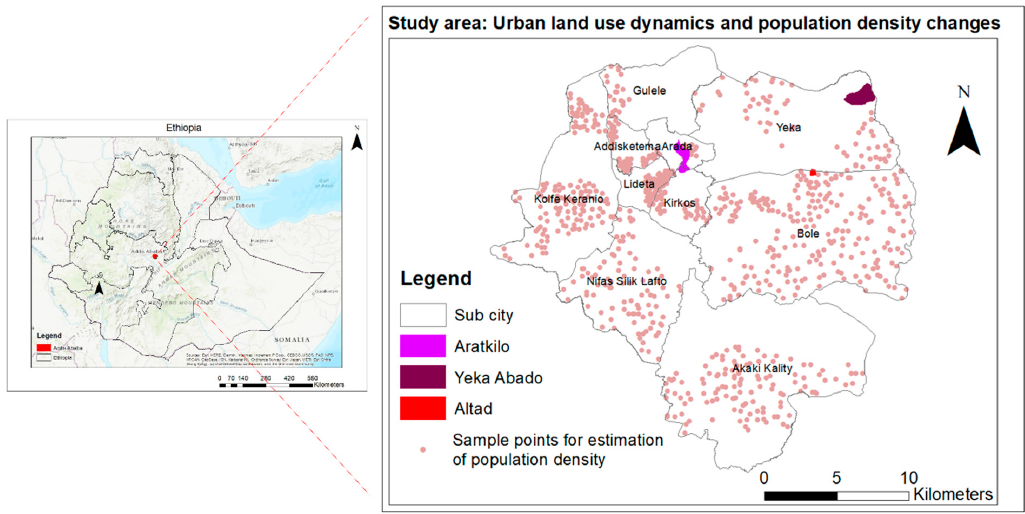
Figure 1. The study area, Addis Ababa, the capital of Ethiopia, is located in East Africa. The city is divided into 10 sub-cities, and the case study areas were selected from the center (Aratkilo), middle distance from the center (Altad), and the periphery (Yeka Abado).